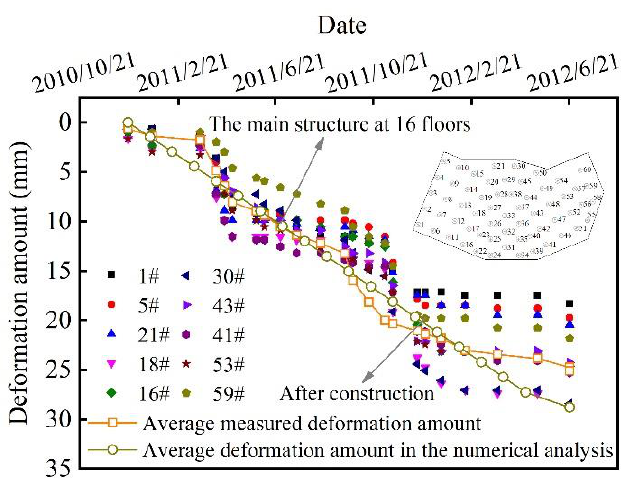
Figure 19. Curve of deformation amount of deformation adjustor variation with time.